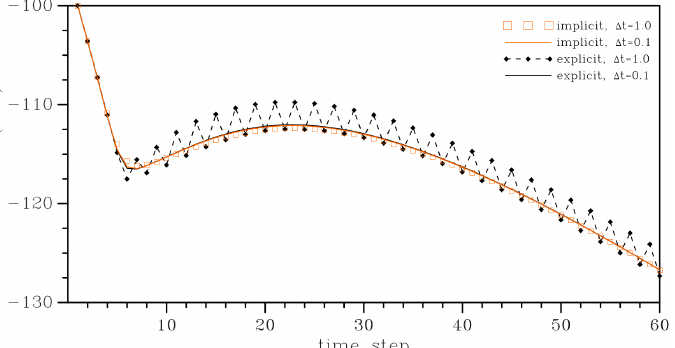
Figure 5. Test 2. Time evolution of σ 11 stress at different time steps for explicit and implicit time integrations.